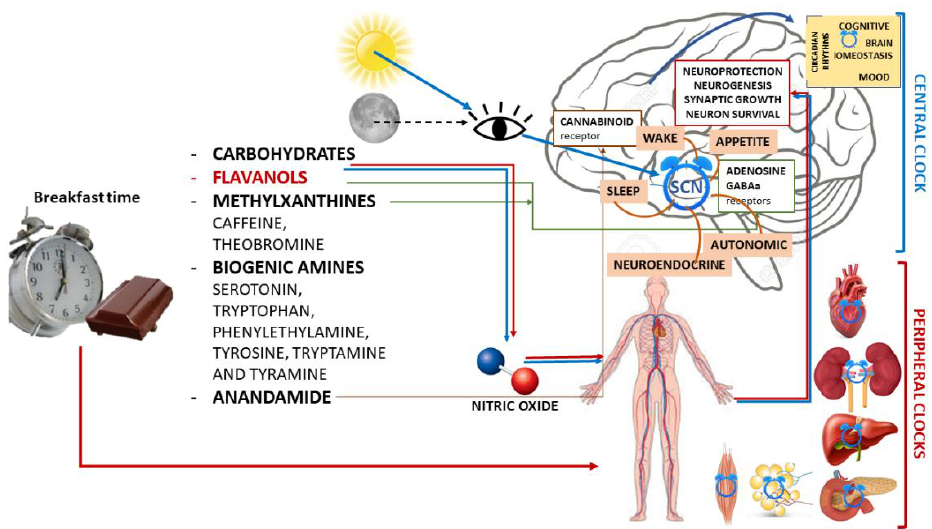
Figure 1. Schematic illustration of chrononutrition with chocolate for breakfast and components of chocolate with the main mechanisms of action in both the central nervous system and peripheral organs and their actions.